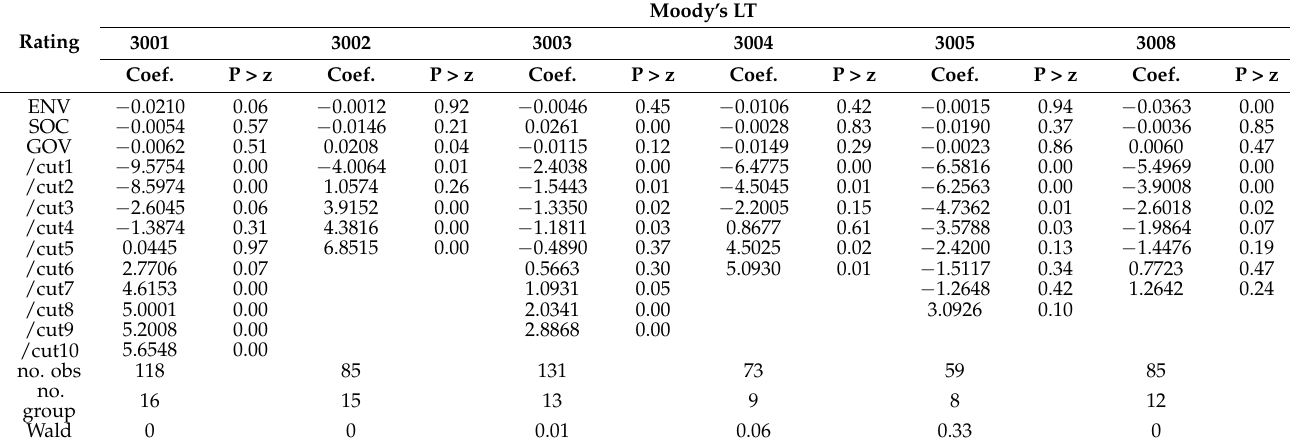
Table 8. Impact of the ESG measures on Moody’s long-term issuer credit ratings by